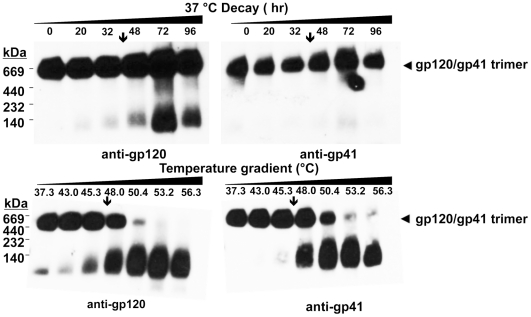
Time course incubation of HIV-1 Env trimers at physiological temperature (37°C) visualized using BN-PAGE.(A) HIV-1LAI-JR2 MC, produced in 293T cells, was incubated for various time intervals up to 96 h at 37°C and aliquots removed for BN-PAGE and Western blot analysis, as in
Fig. 4
. Down arrows indicate the time interval in which infectivity of the cognate virus decreases by ≥90%. The band smearing in the 72 h lane is an experimental artifact of sample loading. (B) The same virus sample as in Panel A was subjected to indicated temperatures for 1 h and analyzed on BN-PAGE, as in
Fig. 4
, except that the electrophoresis run time was shorter causing less separation between different bands.